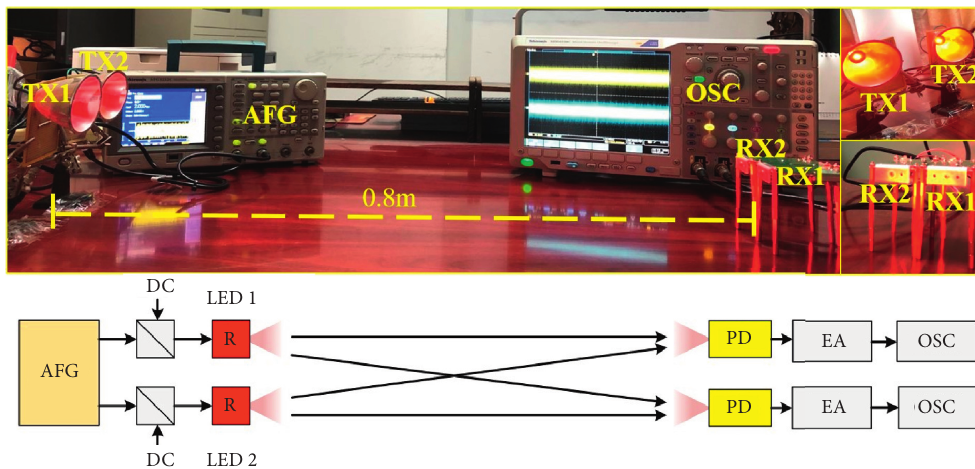
Figure 2: Experimental setup of the MIMO-OFDM VLC system based on ZCT precoding.